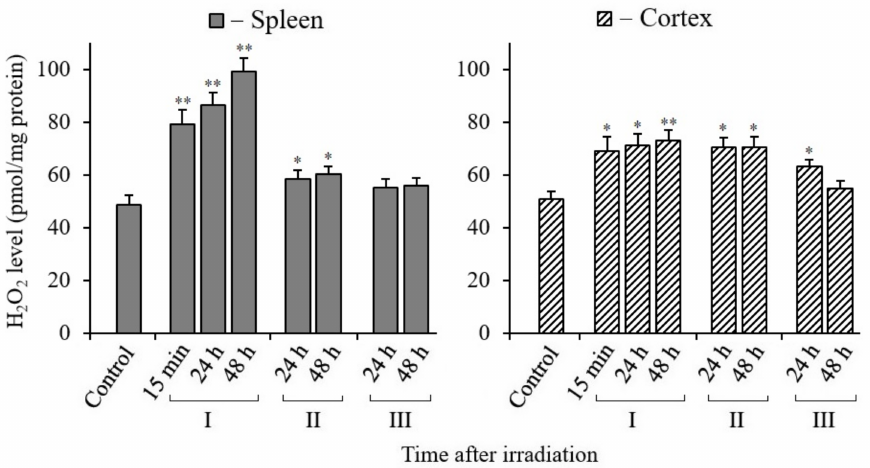
Figure 4. Changes in the H 2 O 2 content in spleen and cerebral cortex tissues of mice 15 min, 24, and 48 h after their exposure to X-rays. I—mice groups without MEL administration; II—MEL administration before irradiation; III—MEL administration after irradiation. The data are presented as mean ± SEM of 5–6 independent experiments. Statistical significance was set at * p < 0.05; ** p <